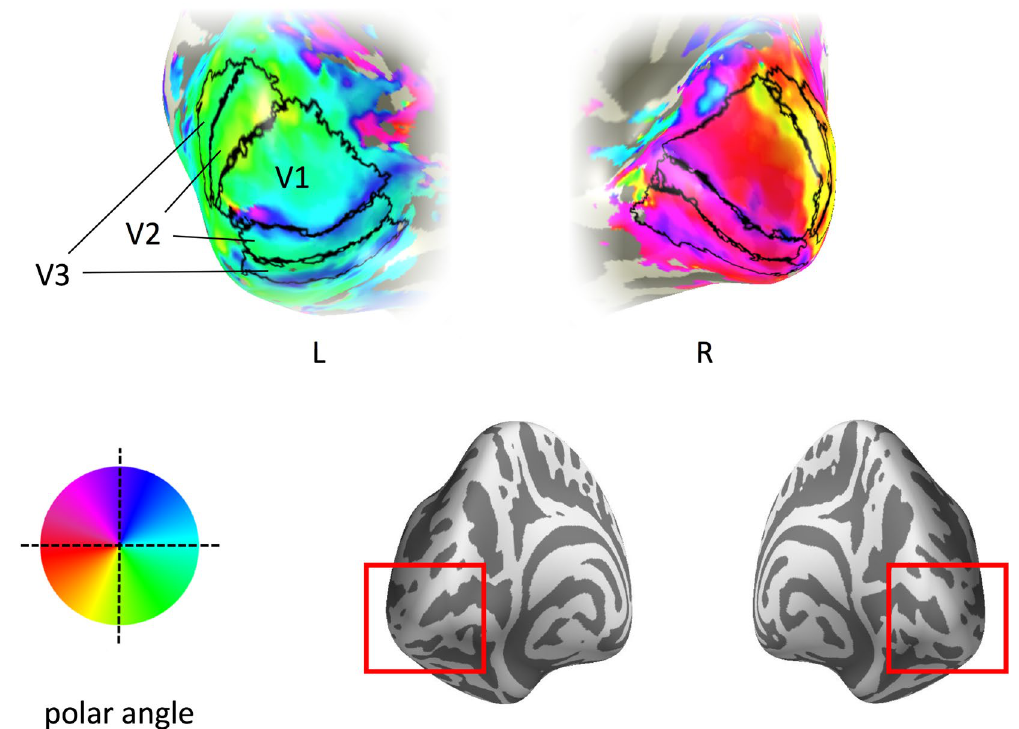
Figure 2. Early visual cortical regions for a representative participant. Visual areas are superimposed onto the occipital lobe – see red insert on the posterior view of the inflated brain. Colour maps indicate the preferred polar